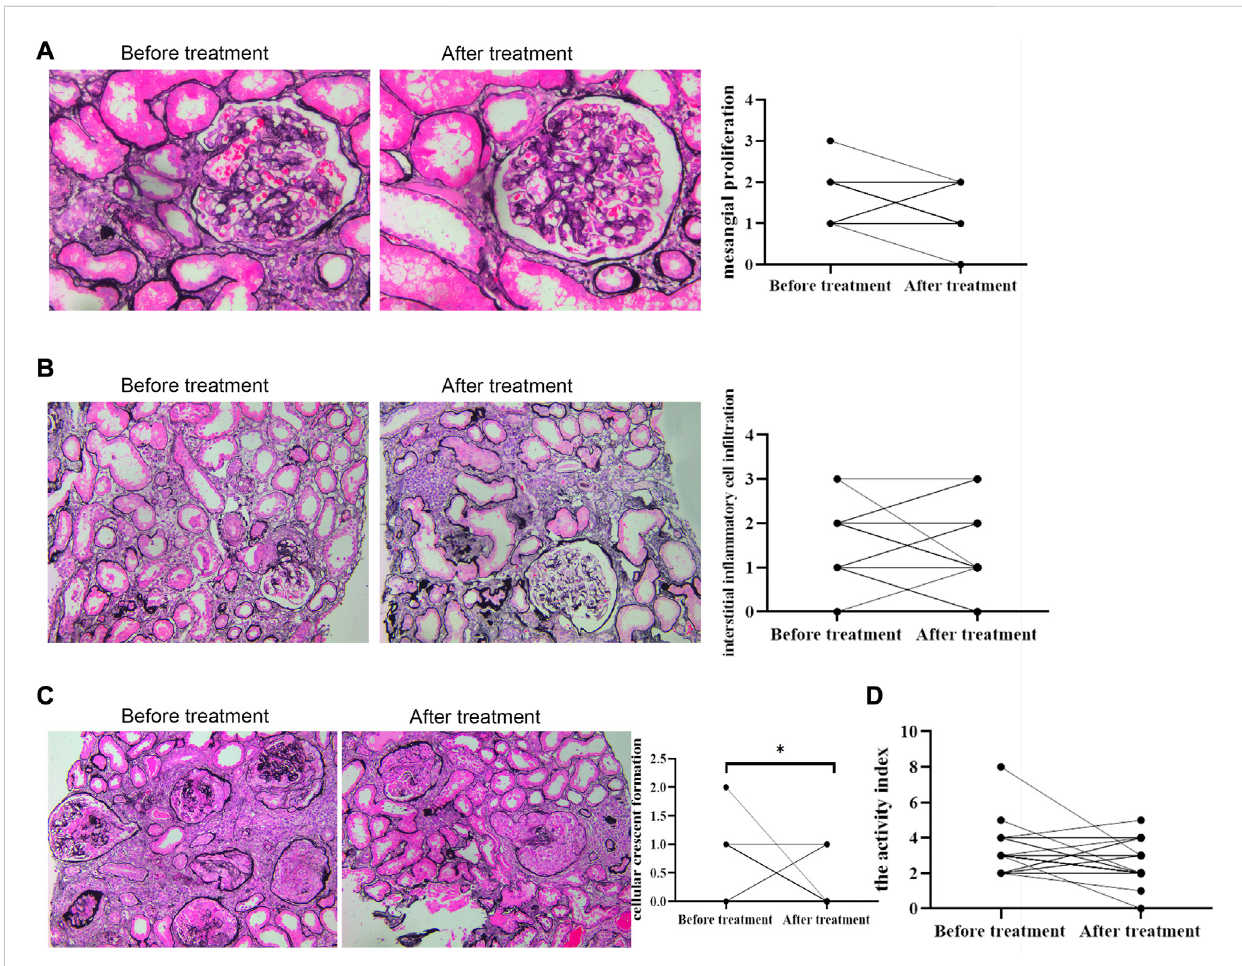
FIGURE 3 Acute renal pathological changes before and after treatment by PAS staining. Scale bar: 50 μ m. Activity indexes of renal lesions were evaluated by Andreoli scoring method. * represented that P was less than